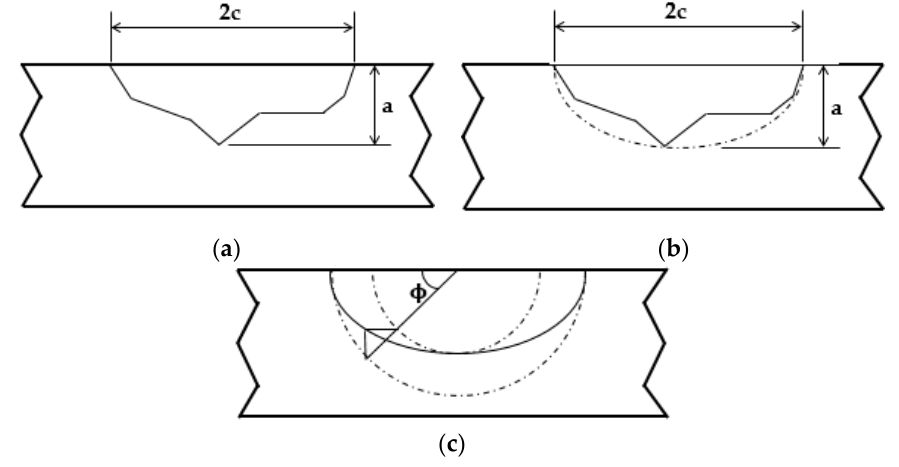
Figure 2. ( a ) Real crack with arbitrary dimensions; ( b ) idealized surface crack; ( c ) parametric semielliptical angular